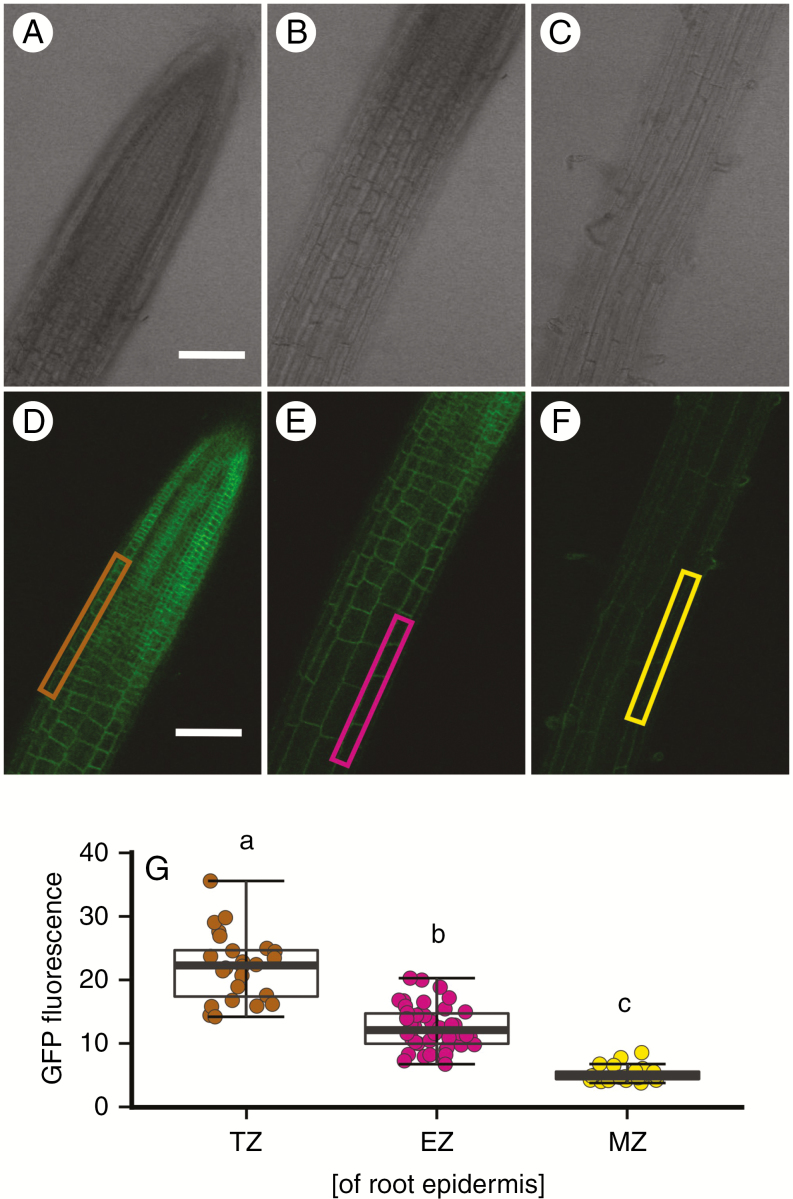
DORN1 abundance declines as primary root cells mature. (A–F) Confocal microscopy images of the different zones of 14-d-old Arabidopsis root expressing a DORN1-GFP fusion from the native promoter. Epidermis in the transition zone (TZ) is marked by brown rectangle, elongation zone (EZ) by pink, and mature zone (MZ) by yellow. Scale bar = 100 μm for all. (G) Background-subtracted DORN1-GFP fluorescence of epidermis in the transition zone (TZ, brown), elongation zone (EZ, pink) and mature zone (MZ, yellow) of 14-d-old Arabidopsis roots. GFP-signal was measured from the plasma membrane of epidermal cells and normalized to cells not expressing GFP; n = 24 (TZ/MZ) and n = 44 (EZ) from six individual plants. Analysis of variance (ANOVA) with post-hoc Tukey test was used to assess statistical differences, and different letters indicate significant difference (P < 0.001).